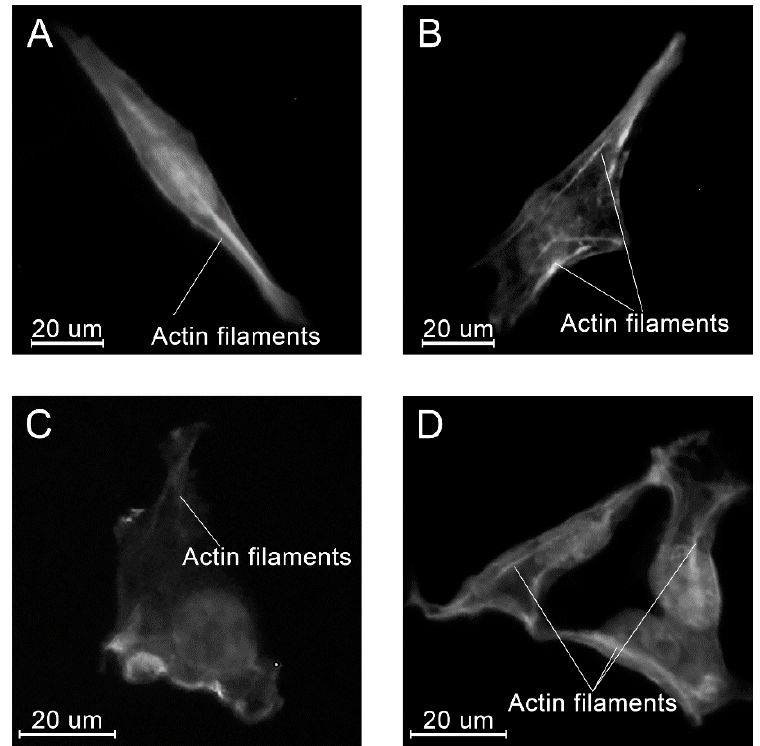
Figure 17. Examples of the morphology of the MG-63 cells, 24 h after seeding on the specimens of different materials: PLAMA-500 ( A ); PLAMA-1000 ( B ); PLDL ( C ); SS ( D ).